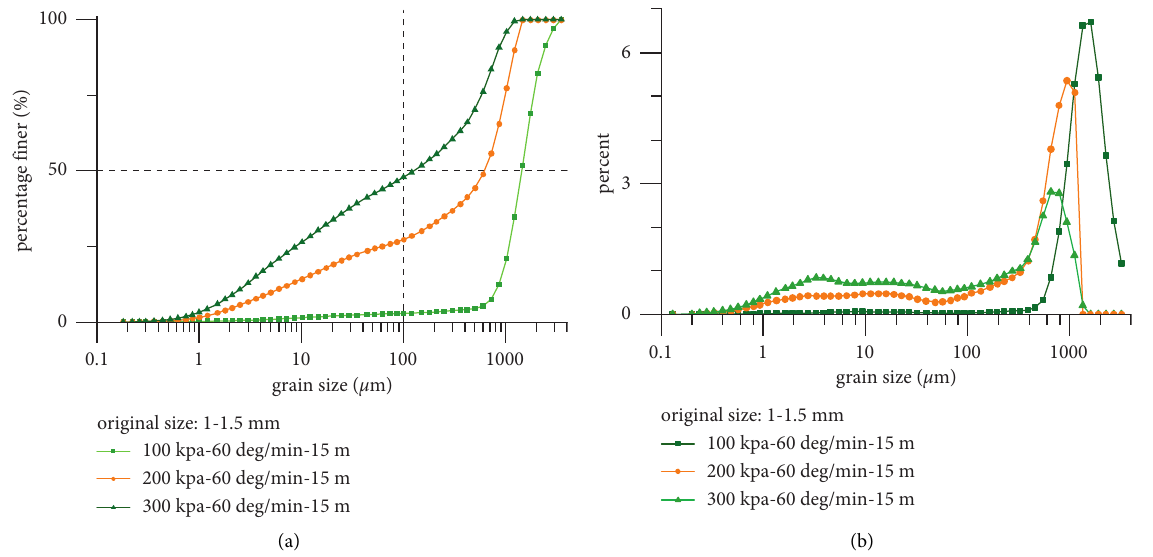
Figure 5: Evolution of grain size distribution with normal stresses. (a) Cumulative grain-size distribution curves after shearing at 15m at a shear rate of 60deg/min under the normal stresses of 100kPa, 200kPa, and 300kPa. (b) Frequency grain-size distribution curves after shearing at 15m at a shear rate of 60deg/min and under the normal stresses of 100kPa, 200kPa, and 300kPa.